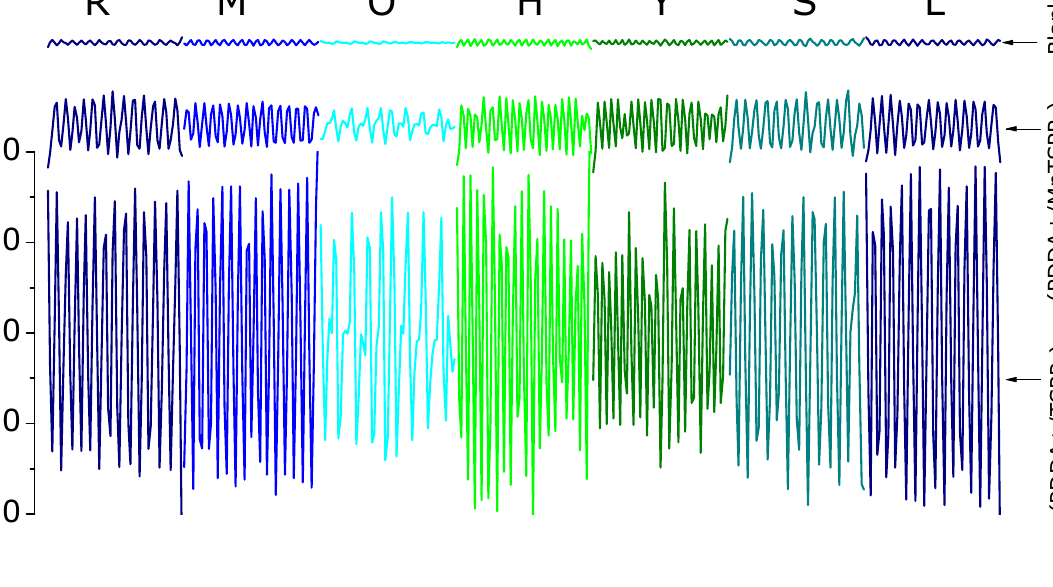
Figure 9. Differential respiratory patterns for seven participants in the RR measurement experiment, as responses of two QCM electrodes modified with functional films and uncoated